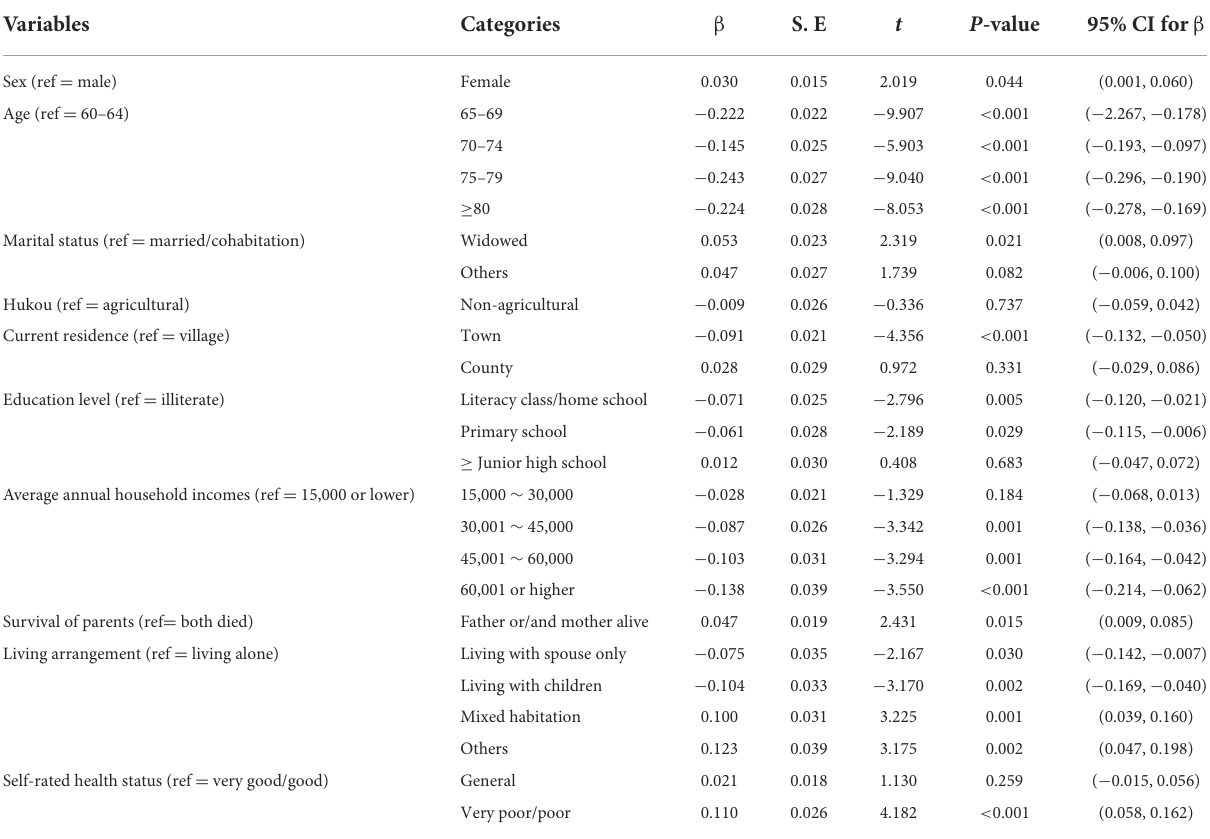
TABLE 3 Predictors of factors associated with the total score of SCL-90-R among the Hakka